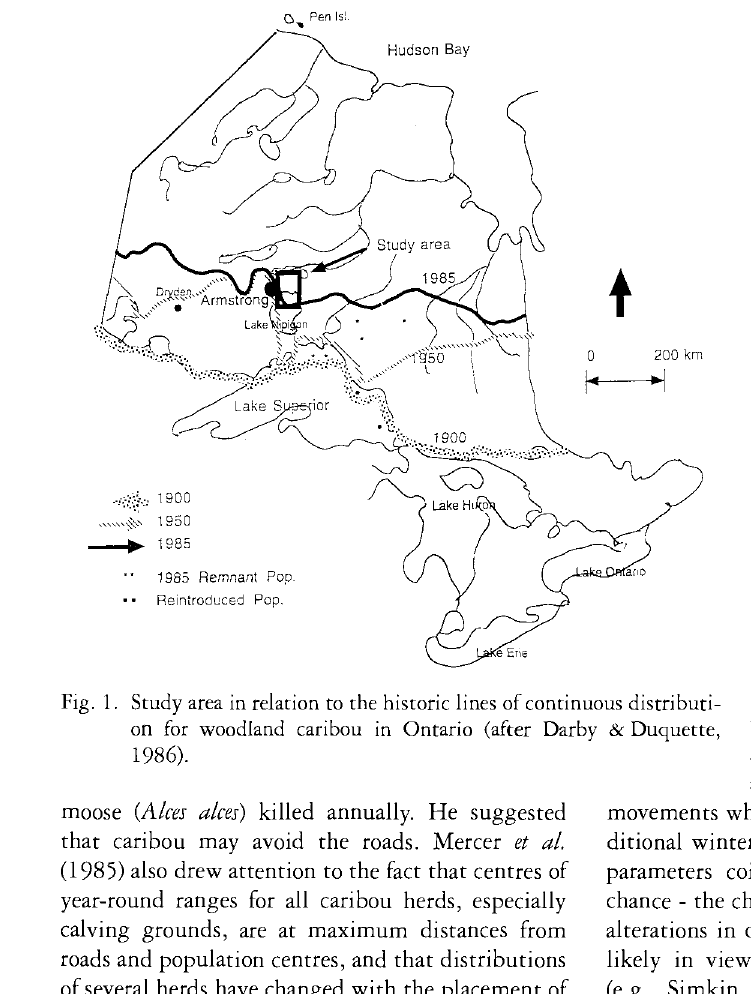
Fig. 1. Study area in relation to the historic lines of continuous distributi on for woodland caribou in Ontario (after Darby & Duquette